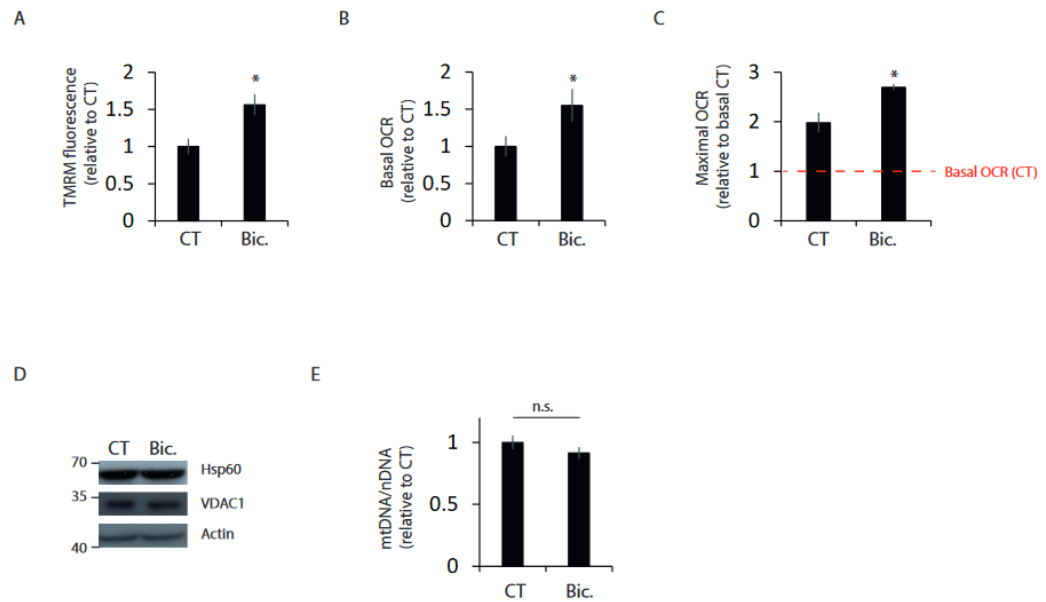
Figure 1. Synaptic activity enhances mitochondrial bioenergetics. Primary cortical neurons were stimulated with bicuculline plus 4-AP (labeled Bic in this and subsequent figures) for 24 h or left unstimulated (CT), 30 min after washing out to block burst firing: ( A ) mitochondrial membrane potential (MMP) was determined by measuring TMRM fluorescence (n = 4 independent experiments). ( B ) Basal and ( C ) maximal oxygen consumption rate (OCR) was analyzed (n = 3 independent experiments). ( D ) Representative Western blots of protein samples of control and stimulated neurons (n = 3 independent experiments). ( E ) Mitochondrial and nuclear DNA was analyzed by qPCR (n = 4 independent experiments). * p < 0.05, two-tailed Student’s t -test. n.s. = non-significant.